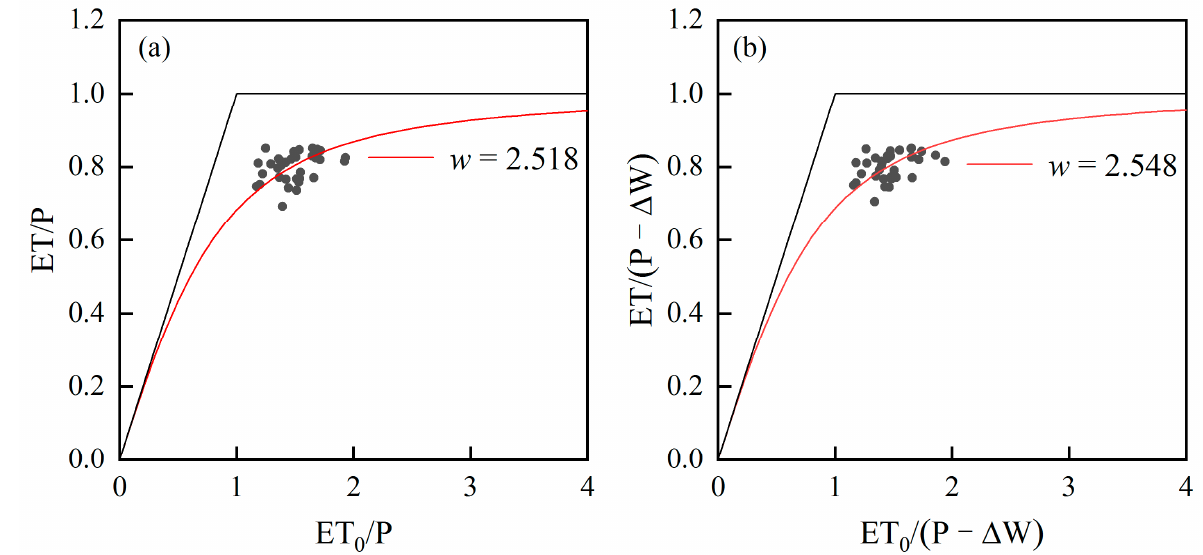
Figure 6. Relationships between annual ET/P and ET 0 /P in the original Budyko framework ( a ), and in the extended Budyko framework with glaciers ( b ).